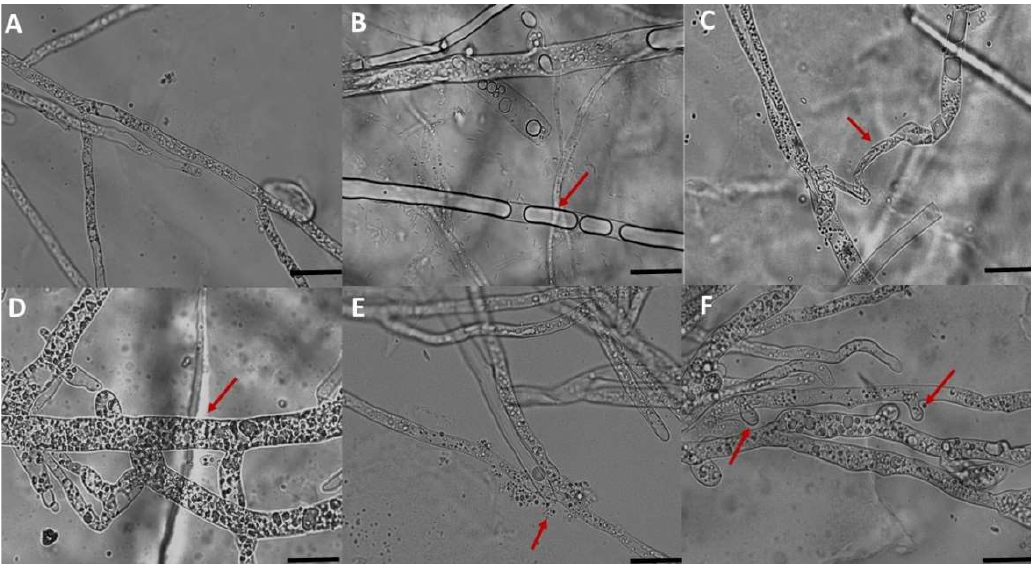
Figure 2. Microscopic observation (×40) of the hyphal structure of P. schmitthenneri co-cultured with the antagonistic bacteria after 6 days of incubation. ( A ) untreated control; ( B ) vacuolation (SF14); ( C ) deformation (ACBC2); ( D ) hyphal swelling (ACBC1); ( E ) degradation of the mycelium (BM3-5); ( F ) budding of the mycelium structure (Bel3-4). Changes in the hyphae and mycelia are indicated by arrows. Scale bar = 20 µm.